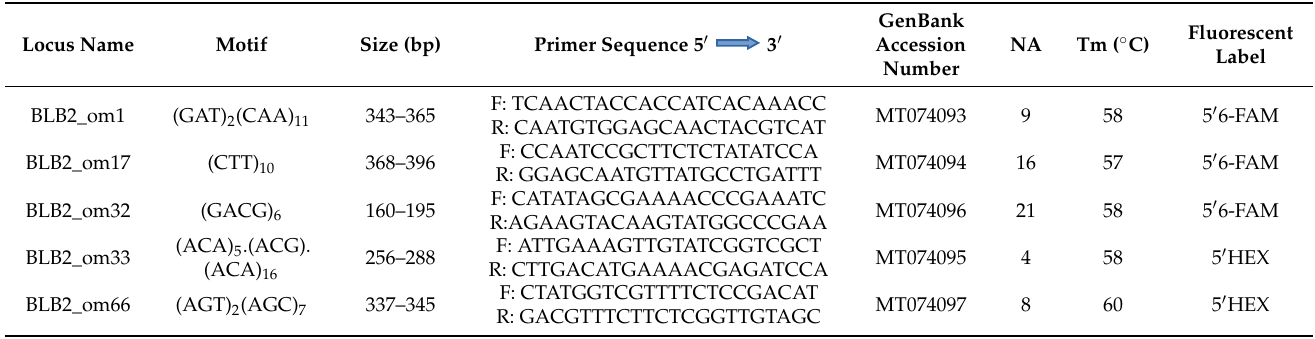
Table 3. Characteristics of the five microsatellite loci developed and used for the Ootheca mutabilis population genetic study. NA (Number of alleles).